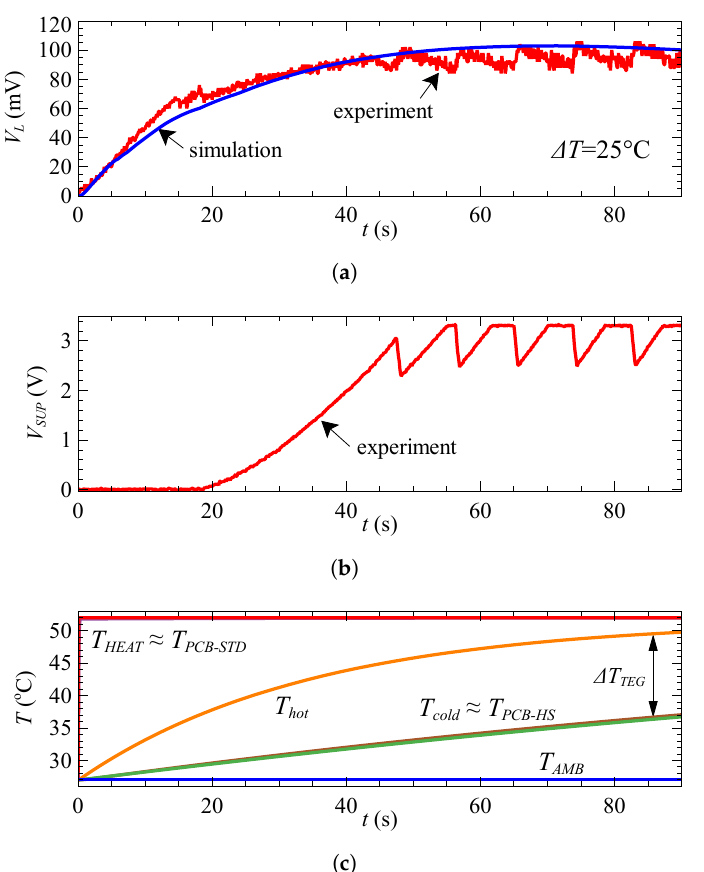
Figure 10. Voltages and temperatures in the complete WSN node for ∆ T = T HEAT − T AMB = 25 ◦ C: ( a ) Load voltage vs. time; ( b ) Power supply voltage vs. time; ( c ) Temperatures at characteristic interfaces vs. time (SPICE